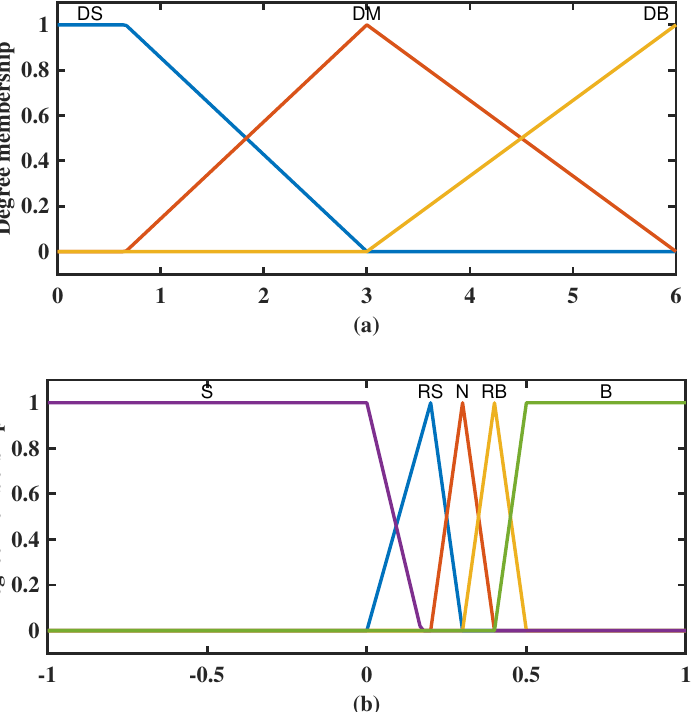
Figure 6. Membership functions of input parameters ( a ) Membership function of µ ( t ) ; ( b ) Member- ship function of κ ( t )